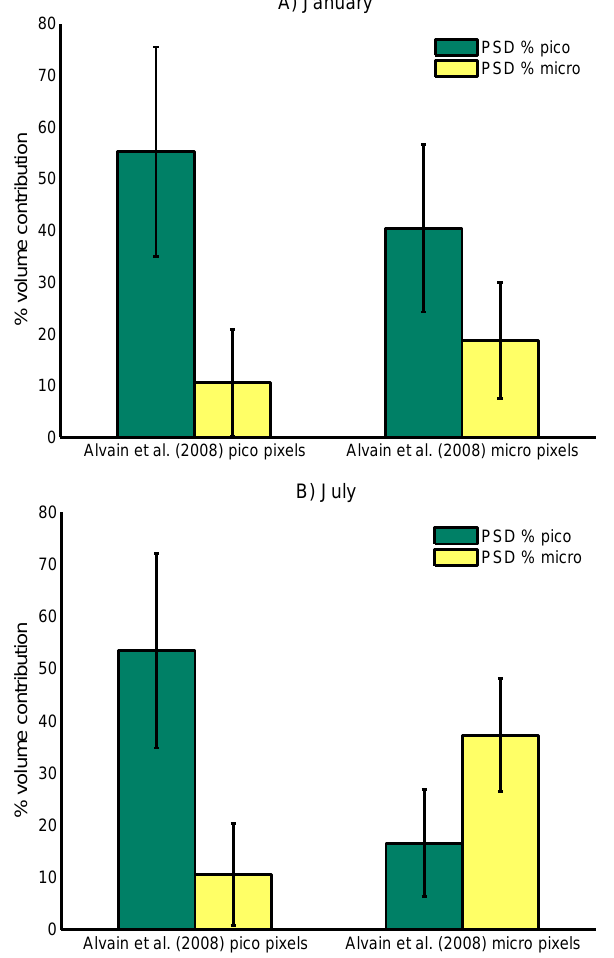
Fig. 12. Bivariate histograms comparing global SeaWiFS decadal averages of the PSD-based and the Uitz et al. (2006) PFT’s. Pixel counts are on a logarithmic scale and are constructed only for pixels deeper than 200m. The one-to-one line is indicated as well. (A) Comparison for picoplankton-sized particles and (B) comparison for microplankton-sized